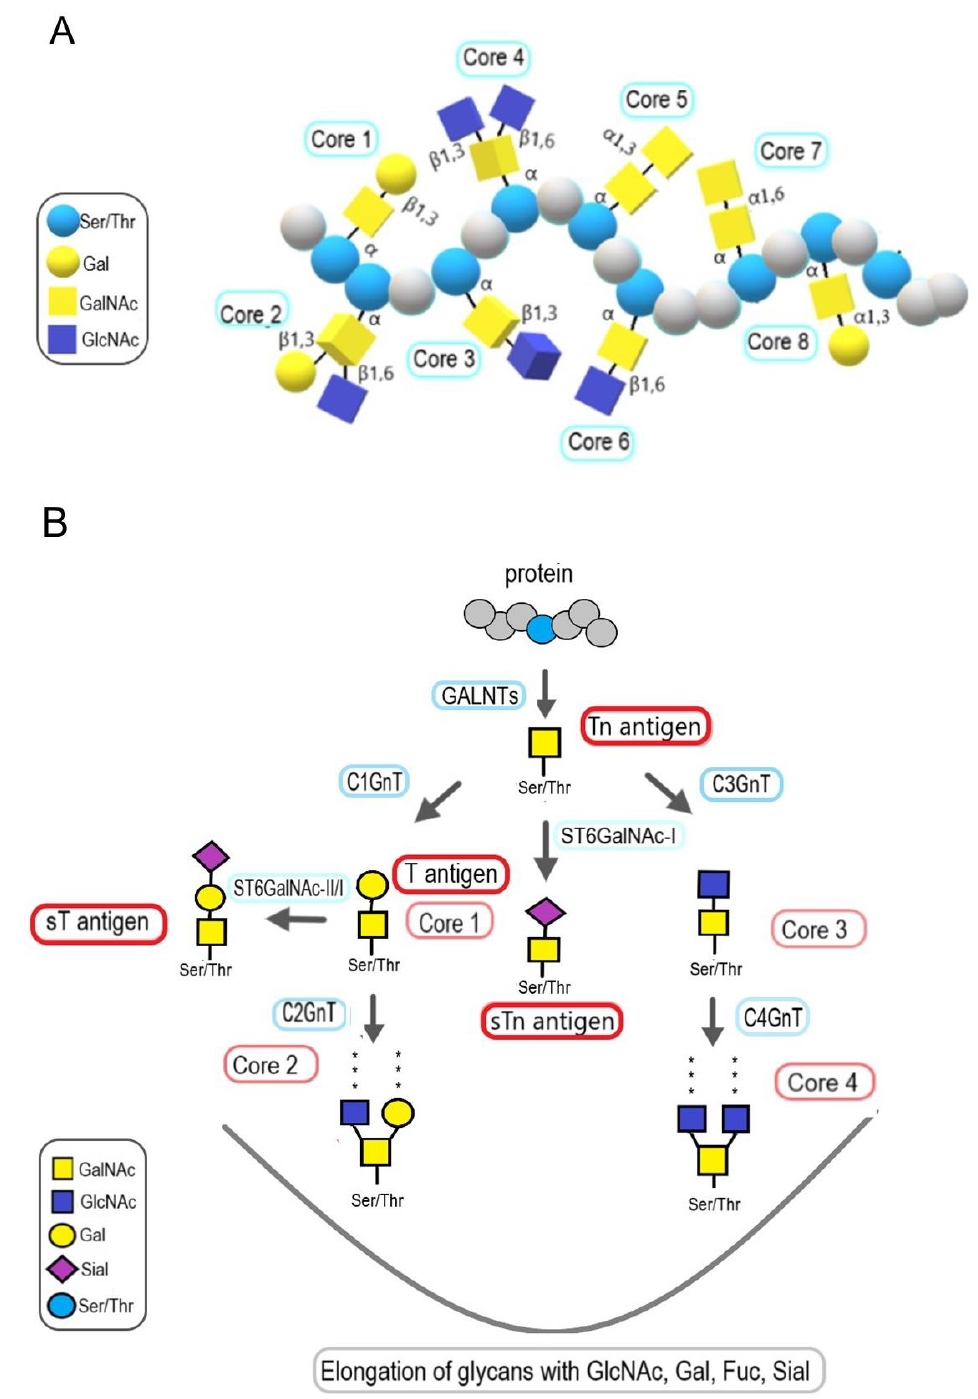
Figure 5. Mucin-type O-glycosylation is initiated in the Golgi apparatus by polypeptide N-acetylgalactosaminyltransferases (GalNAc-Ts, twenty isoforms), which initiates the action of numerous glycosyltransferases catalyzing the attachment of galactose, GlcNAc, fucose, and sialic acid residues that result in the extension of GalNAc into numerous different structures. Mucin-type O-glycosylation leads to the synthesis of eight different core structures. ( A ) Core structures of mucin-type O-glycans. ( B ) Biosynthesis of O-glycan core 1 – 4 structures, their sialylated forms, and enzymes taking part in these processes. During the neoplastic transformation, shortened O-glycan chains are formed. The most common forms are the Tn and T antigens and their sialylated forms.